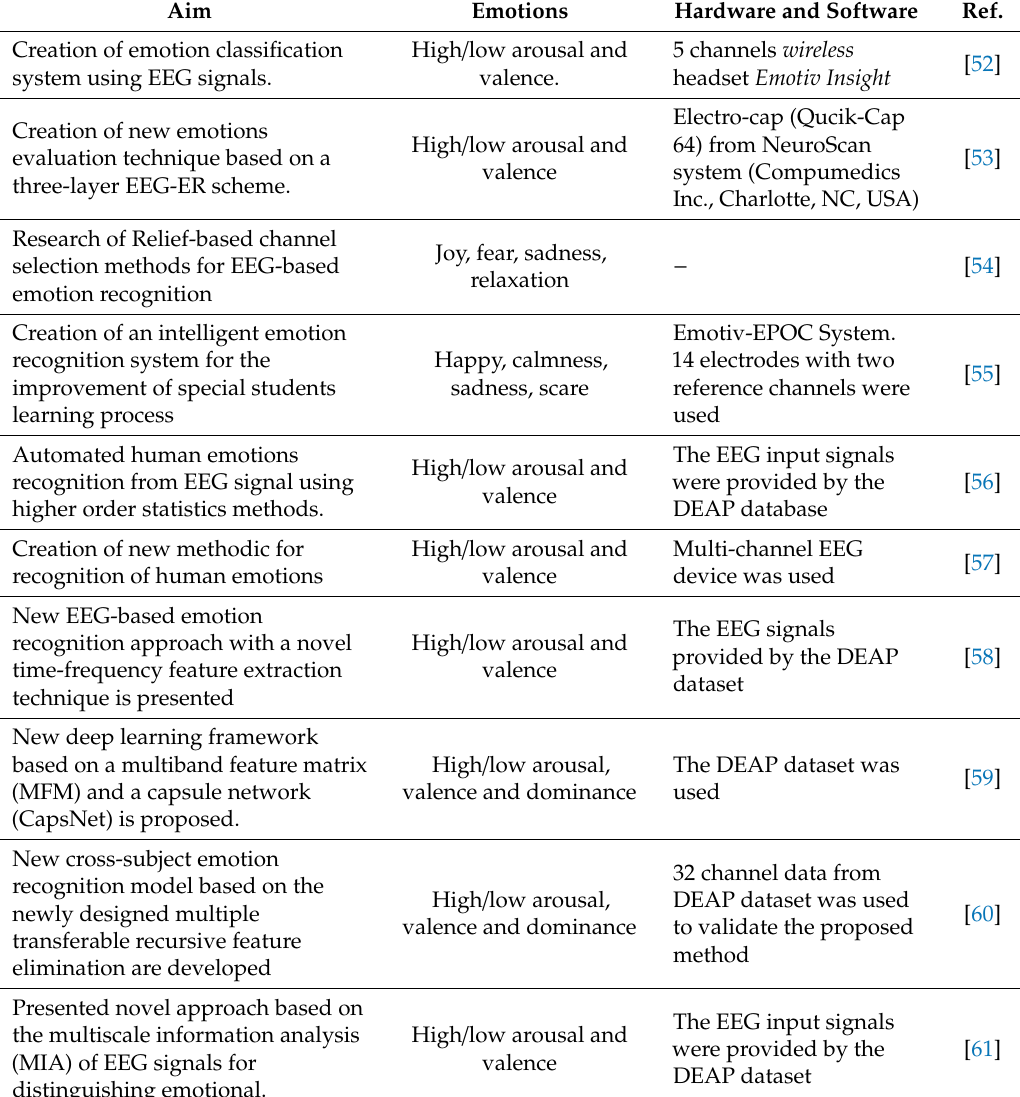
Table 2. Review of scientific researches focused on emotions recognition and evaluation using only electroencephalography (EEG)